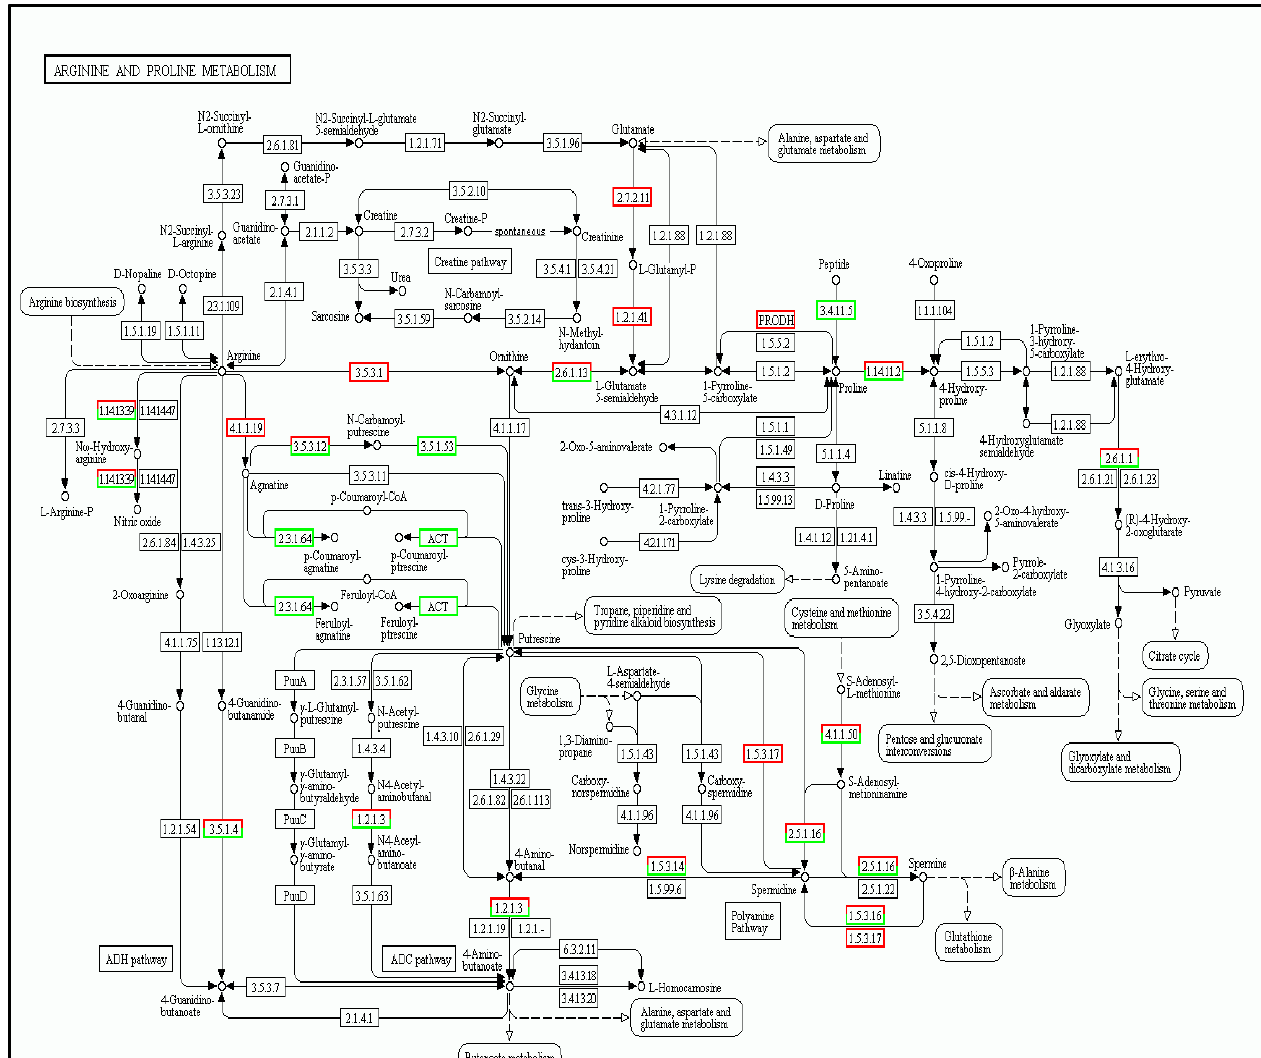
Figure 9. The cold tolerance genes of tea plants involved in proline metabolism pathways. Red boxes representing the upregulation of genes and green ones representing their downregulation.